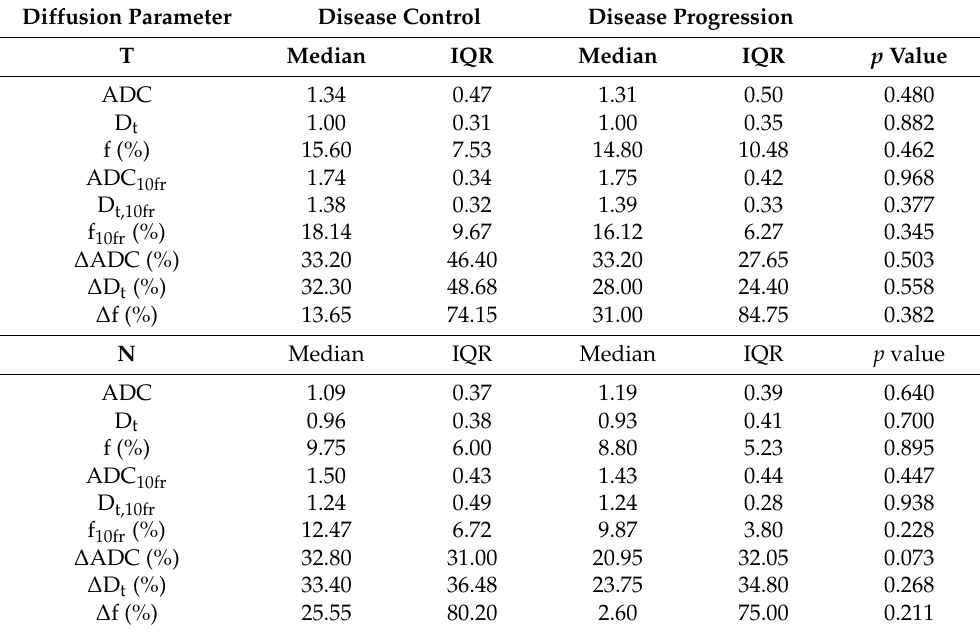
Table 5. Summary statistics of the diffusion parameters and their variations at the 10th fraction in primary tumor (T) and lymph node (N), for patients with and without disease control. Diffusion Parameter